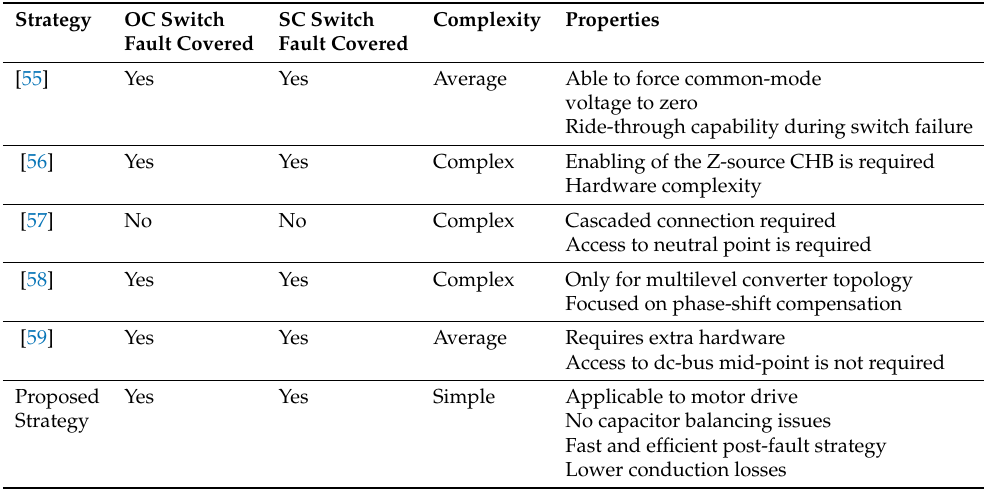
Table 6. Comparative analysis of proposed fault-tolerant strategy with other